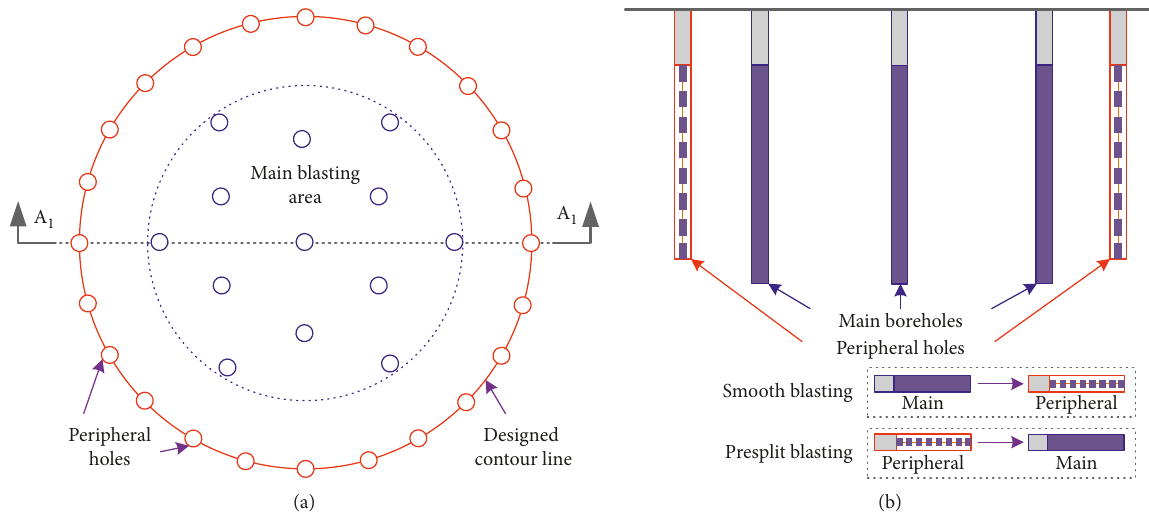
Figure 1: Hole arrangement and sequence of two control methods. (a) Excavation of rock well. (b) A